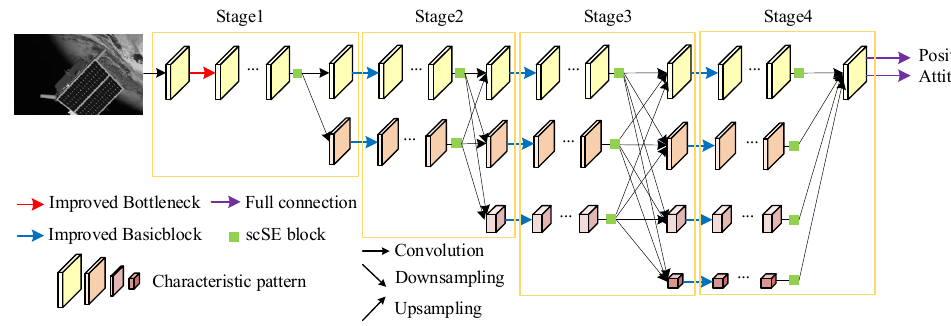
Figure 12. scSE-LHRNet network structure.